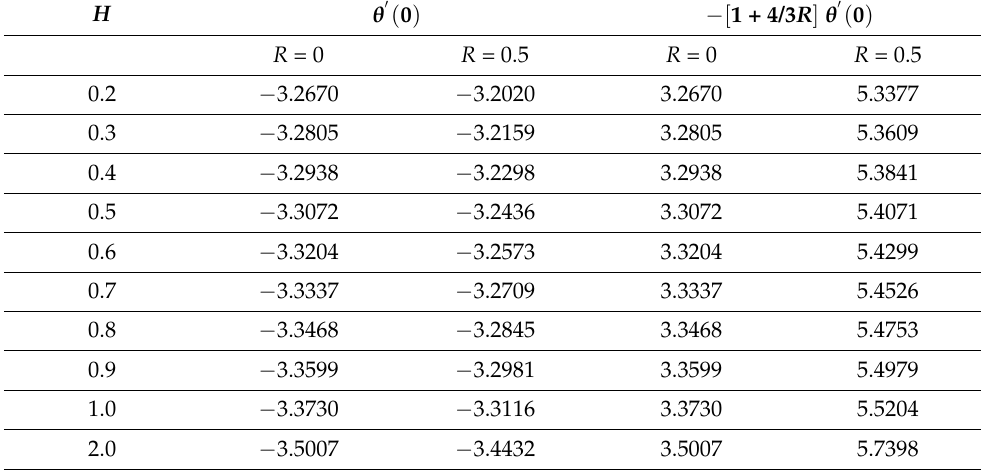
Table 15. Impact of heat generation parameter on Nusselt number for radiative and non-radiative flow